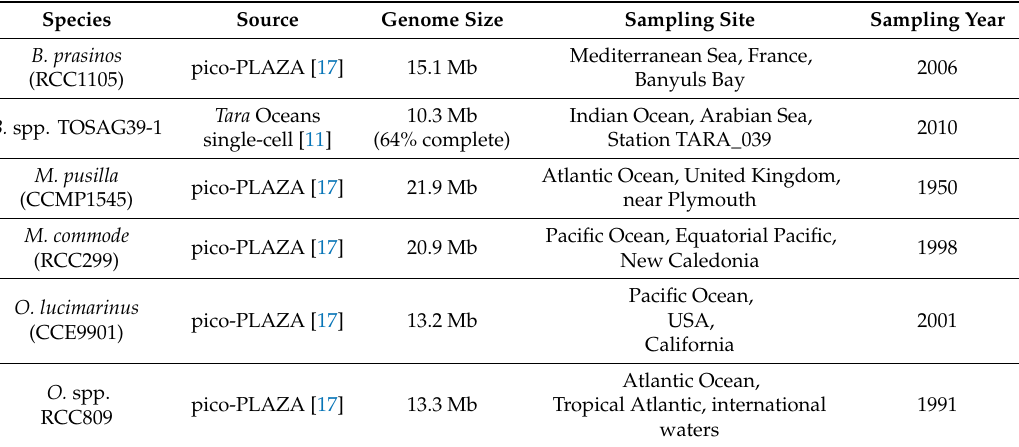
Table 1. Genome data